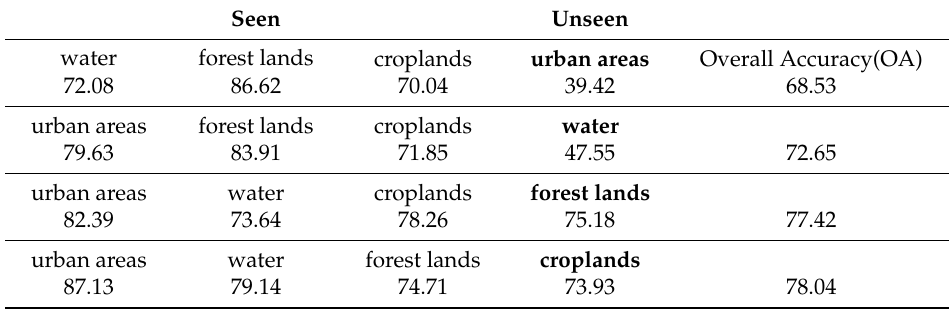
Table 5. The evaluation of GZSL classification results in Flevoland data with different unseen class (%). Seen